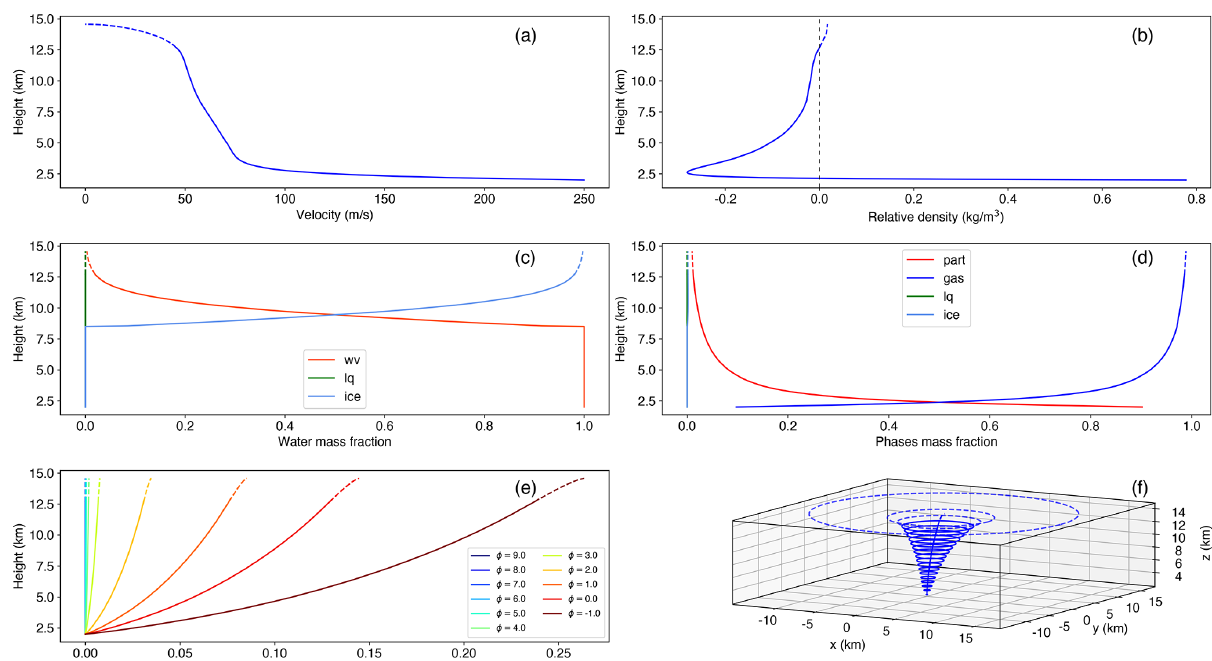
Figure 5. Plume model results for the first phase of the April 2015 Calbuco eruption: (a) velocity profile; (b) relative density, defined as the difference between the density of the volcanic mixture and the density of the surrounding air (with the vertical dashed black line indicating a relative density of zero); (c) relative mass fractions of water phases; (d) mass fractions of particles, gas (water and dry air), liquid water, and ice; (e) relative mass fractions (with respect to the initial amount) of particles lost during the rise for the different bins; (f) three-dimensional view of the plume. Height reported on the left axis of the 2-D plots is measured above sea level. Please note that in all the panels values going up to the neutral buoyancy level are plotted with solid lines, while those corresponding to plume model solutions above the neutral buoyancy level are plotted with dashed